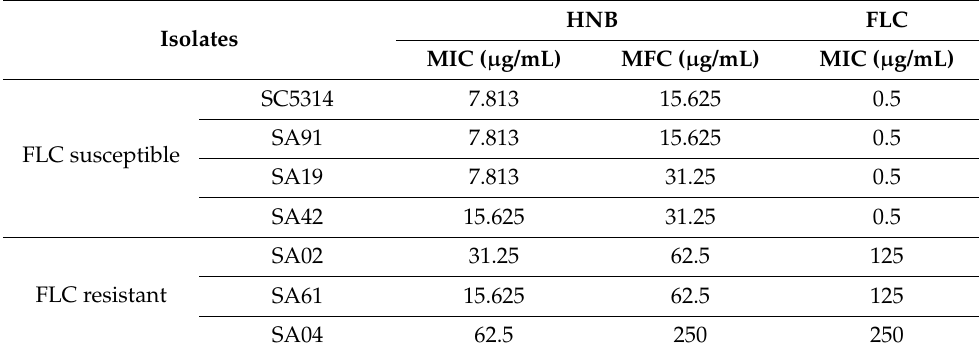
Table 1. Antifungal activity of human neutrophil B peptide against fluconazole susceptible and fluconazole resistant Candida albicans